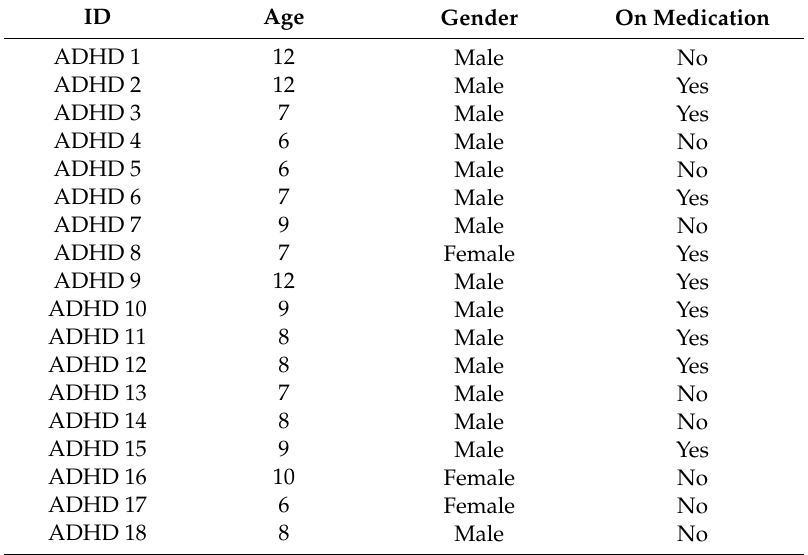
Table 1. Participant demographics for ADHD diagnosed